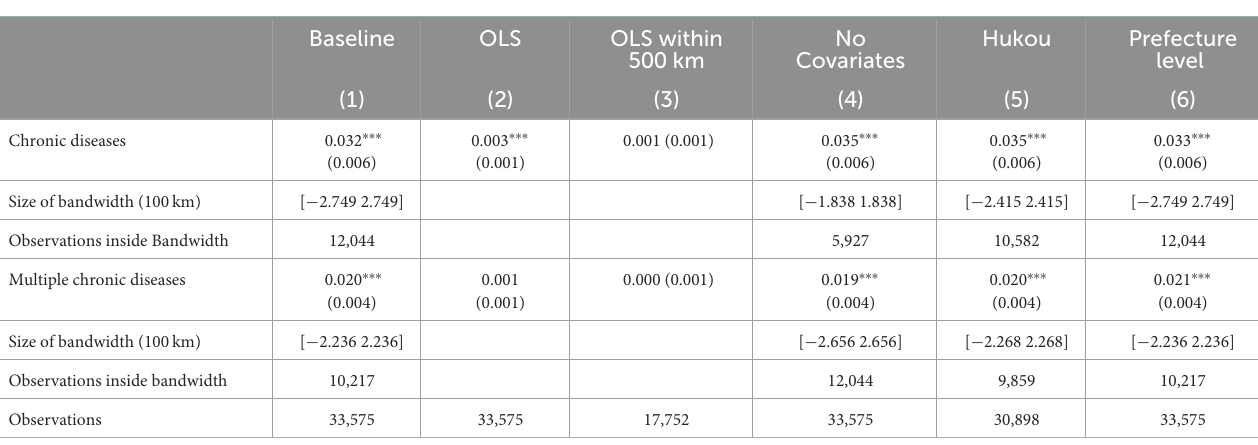
TABLE 6 Robustness of results to alternative specifications and